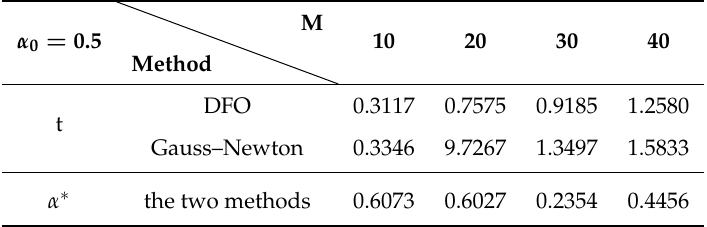
Table 4. The comparison of computational time (unit:s) with α 0 = 1. α 0 =